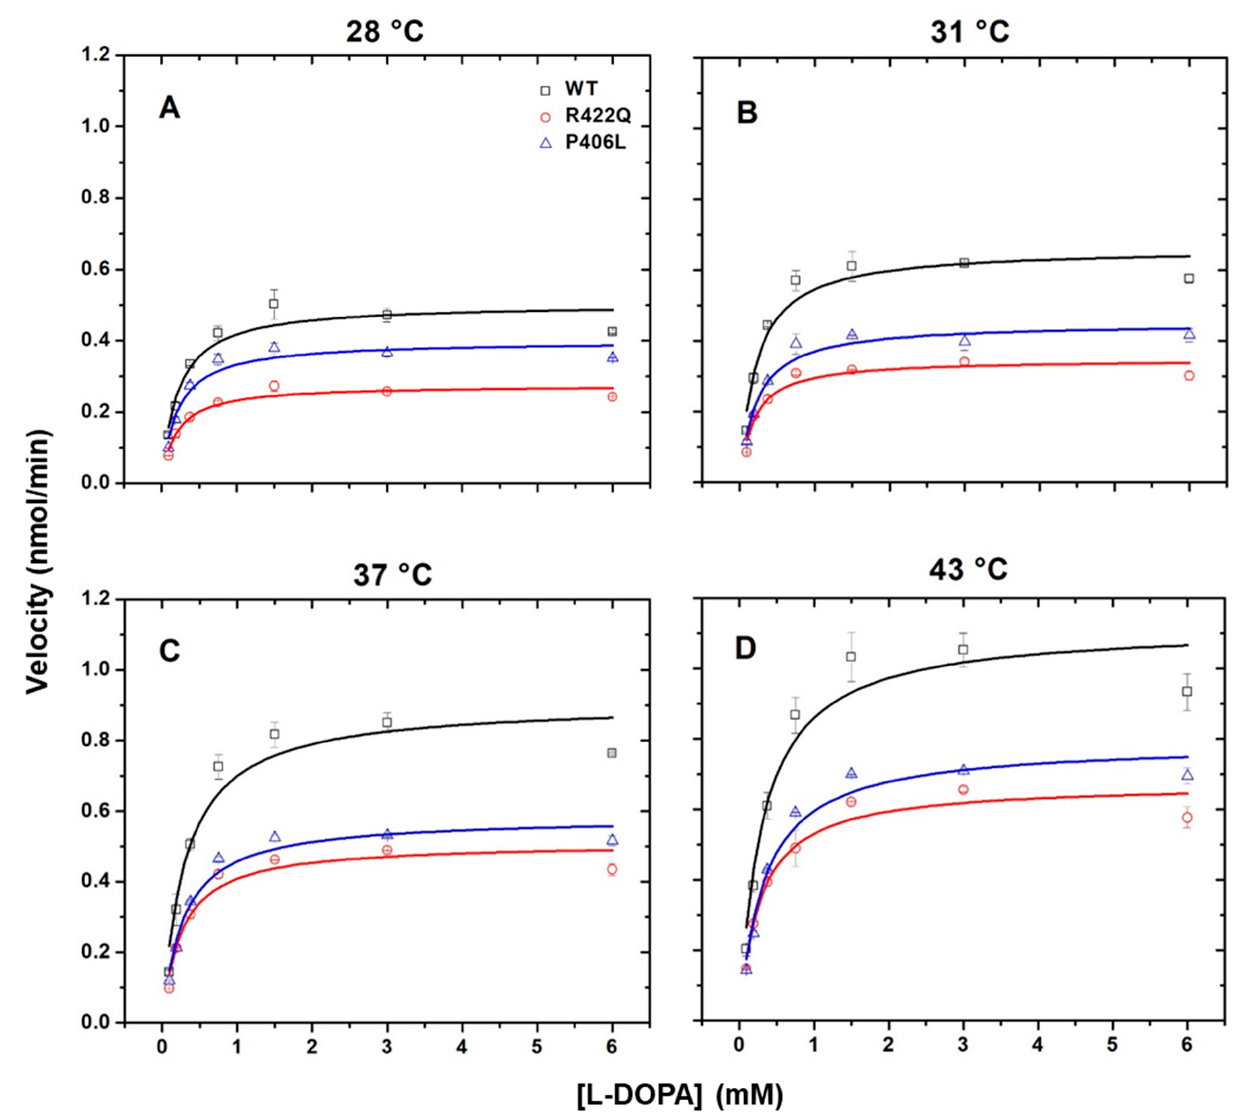
Figure 1. Kinetic analysis of WT and OCA1B-related mutants. Panels ( A – D ) show the Michaelis-Menten plots of diphenol oxidase activity of WT, R422Q, and P406L as a function of L-DOPA concentration measured at increasing temperatures. WT, R422Q, and P406L are shown in black, red, and purple, respectively. Each data point represents the average of duplicate measurements, with error bars representing standard deviations.